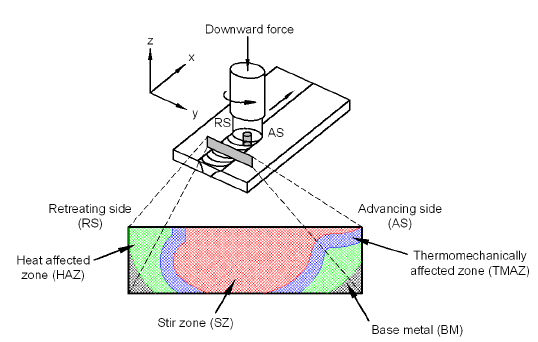
Fig. 1. Schematic drawing of FSW, showing different zones in the cross